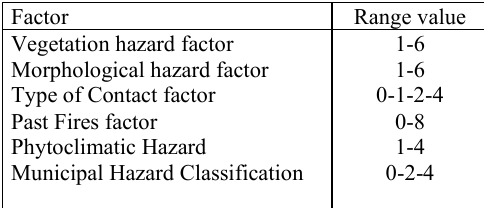
Table 1 . Summary table for defining the calculation of Hazard with range values.